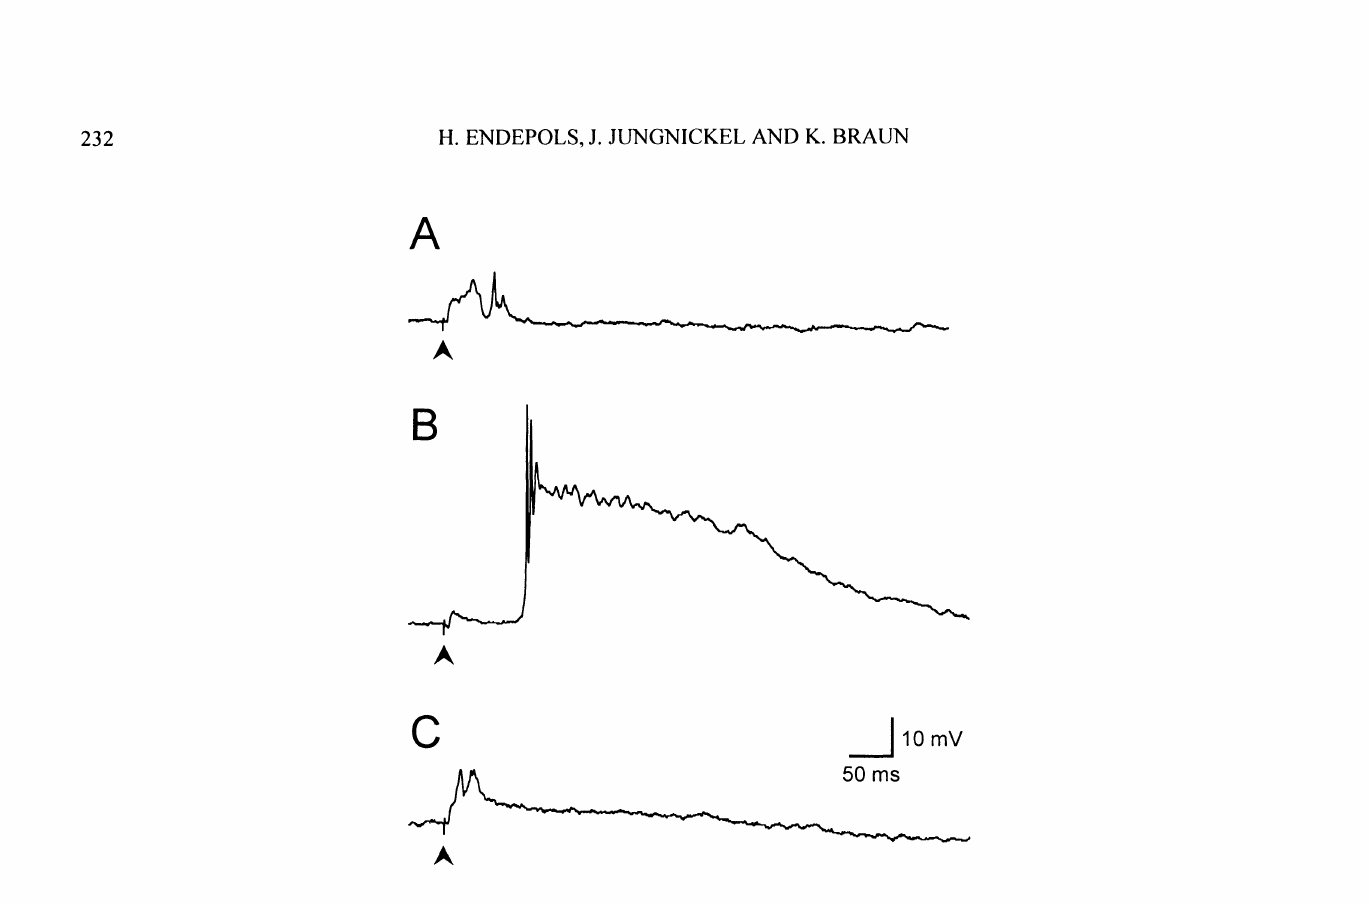
Fig. 10: Bicuculline changes the response of an MNH neuron to single thalamus stimulation. Stimulus artifacts are indicated by arrowheads. A: Control recording. B: 100 laM bicuculline (bath application) blocks the slow PSP component while the fast PSP persists. An additional PSP with long latency and high amplitude appears. C: After 15 min